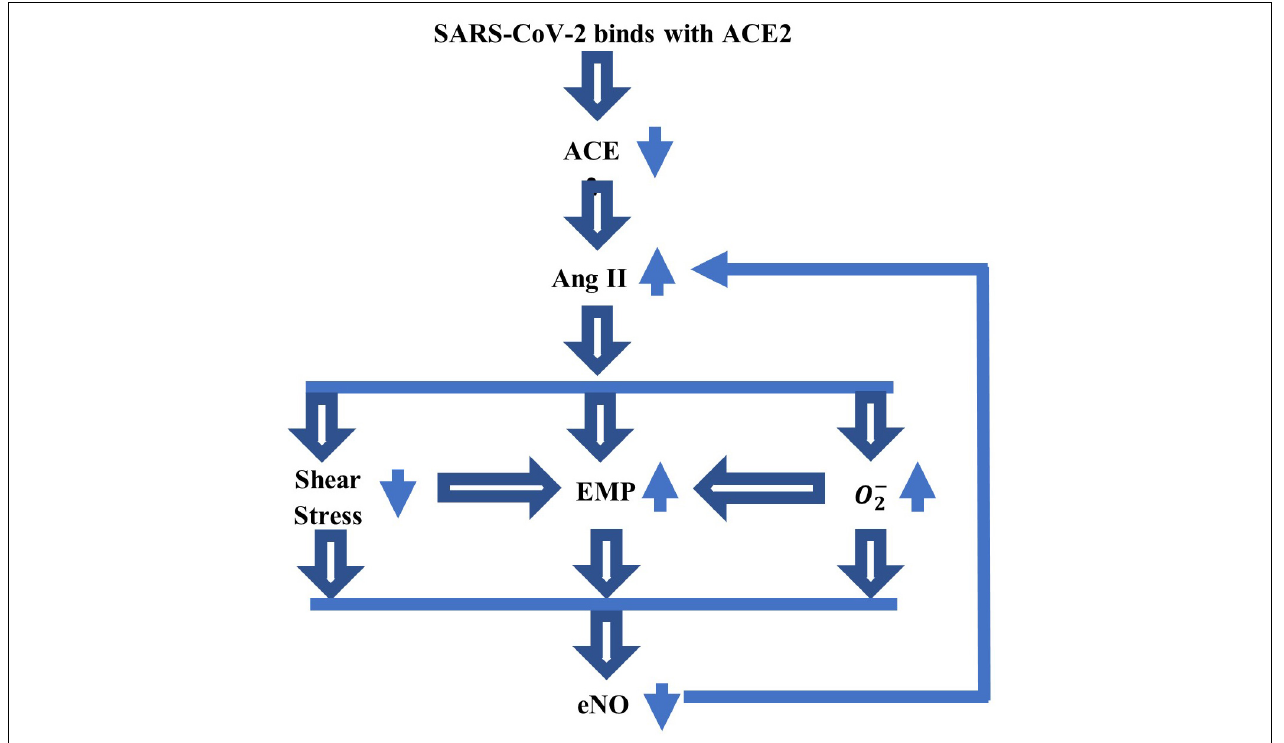
FIGURE 1 | A schematic of the link between SARS-CoV-2 virus and endothelial nitric oxide (NO), which could explain some of the serious cardiovascular and neurological symptoms experienced by a part of patients with COVID-19. The binding between the coronavirus and ACE2 reduces the ACE2 bioavailability, which further increases the amount of Ang II. This increase will lower the shear stress at the blood–endothelium interface and increase the amounts of superoxide ( O − 2 ) and endothelial microparticles (EMP). The low shear stress and elevated O − 2 also contribute to the increase in EMP. A decrease in the concentration of endothelial NO (eNO), thus, follows. The feedback mechanism between Ang II and eNO reduces the amount of eNO still